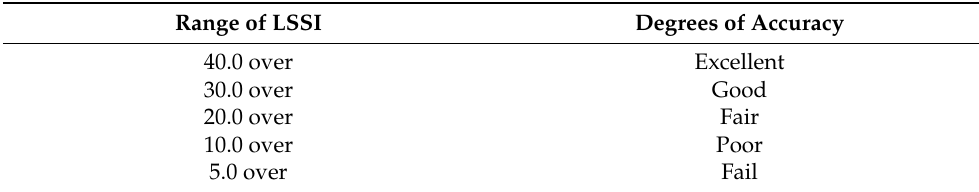
Table 9. Suggested evaluation criteria of the LSSI method.